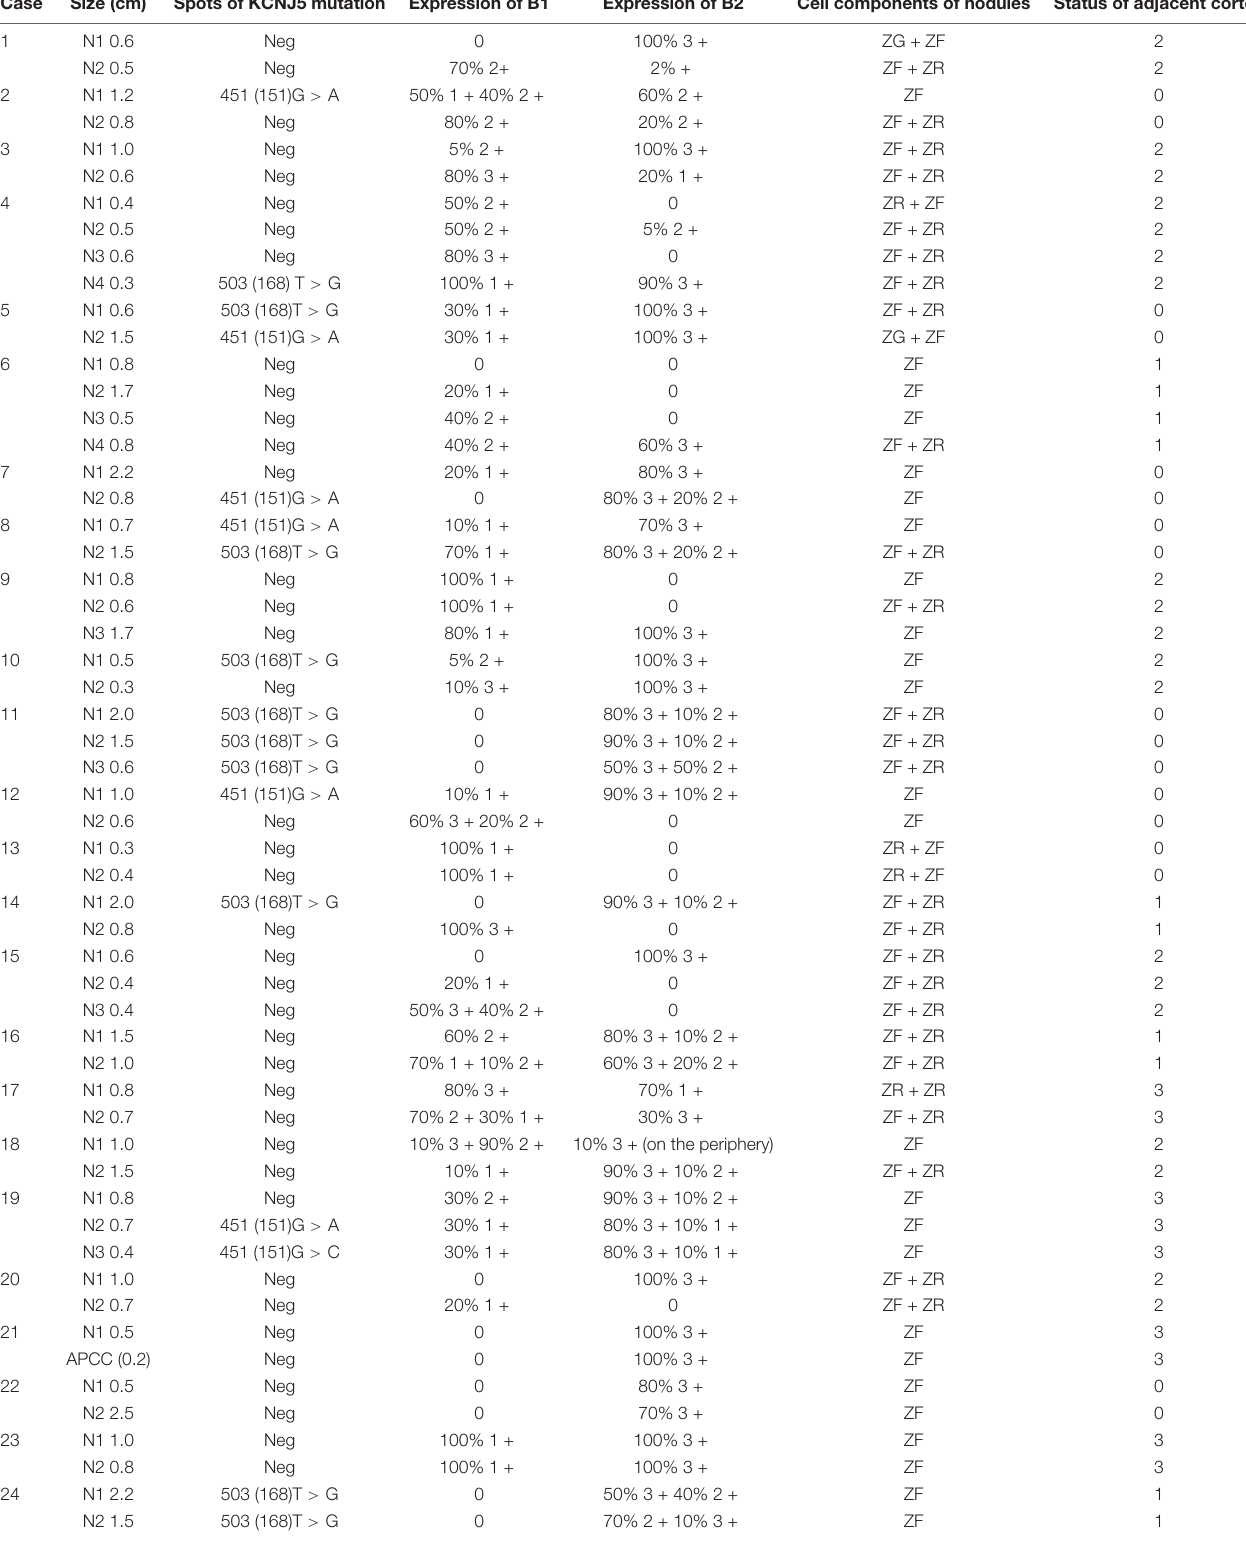
TABLE 3 | Characteristics of 56